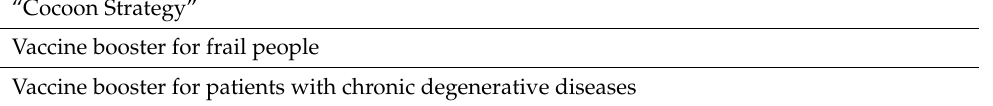
Table 1. Summing up of the main general immunization strategies to be implemented. Vaccination of newborns, pre-school children, adolescents, adults, healthcare workers, childcare workers, pregnant